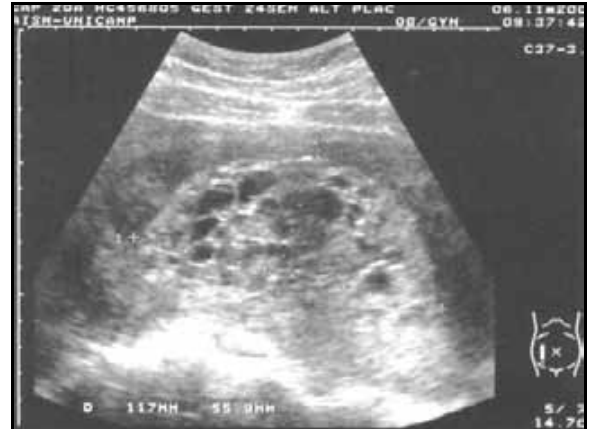
Figura 2 – Imagem macroscópica da